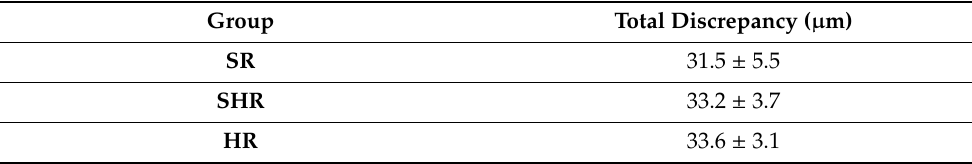
Table 2. Total mean discrepancy ( µ m) by scan